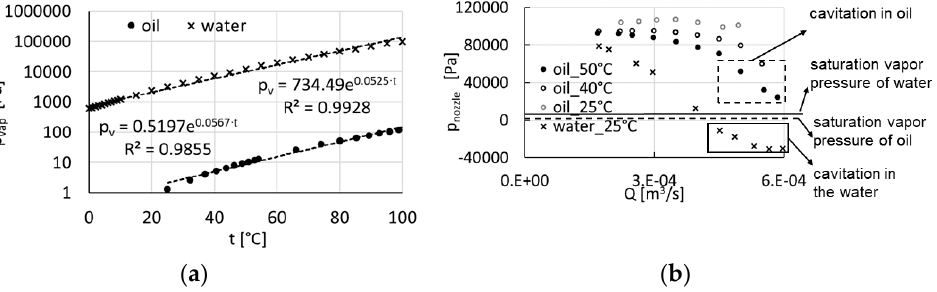
Figure 2. ( a ) Dependence of saturation vapor pressure 𝑝 (cid:3049)(cid:3028)(cid:3043) (Pa) vs. temperature 𝑡 (°C). ( b ) De- pendence of pressure at the narrowest point 𝑝 (cid:3041)(cid:3042)(cid:3053)(cid:3053)(cid:3039)(cid:3032) (Pa) vs. volume flow rate 𝑄 (m 3 · s − 1